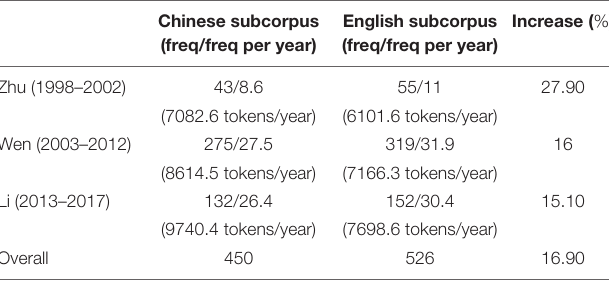
TABLE 3 | Econom* in both subcorpora and across the administrations. TABLE 4 | Collocates of econom* in both